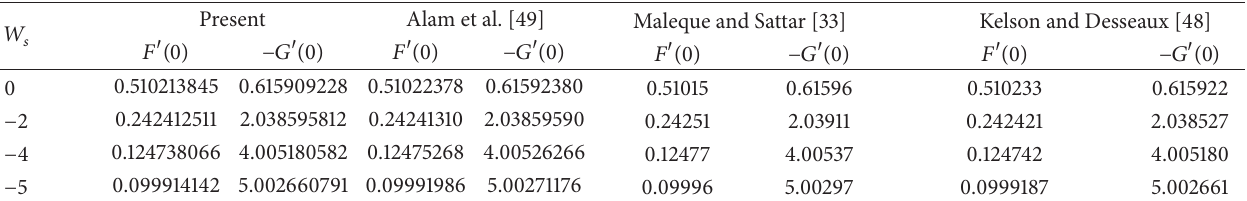
Figure 3: Effect of variation in the suction parameter on the (a) radial, (b) tangential, (c) axial, and (d) temperature velocity profiles when 𝐾 = 1 , Kn = 0.05, Re = 100, 𝑁 = 1 , and Pr = 1. Table 2: Comparison between the results of present study with the results reported by Kelson and Desseaux [48], Maleque and Sattar [33], and Alam et al. [49] for the radial 𝐹 󸀠 (0) and tangential −𝐺 󸀠 (0) skin friction coefficients for Pr = 0.71, 𝑀 = 0 , 𝜀 = 0 , and Kn =